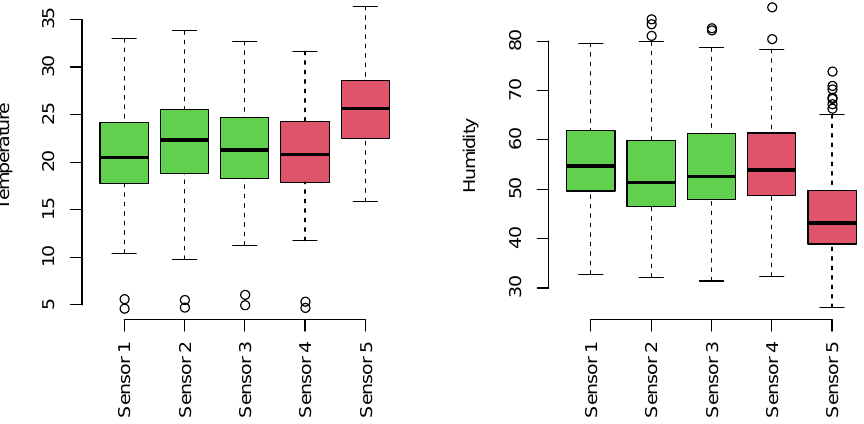
Figure 15. Clustering of CO data for the full period of the study and their visualization with respect to temperature and humidity.